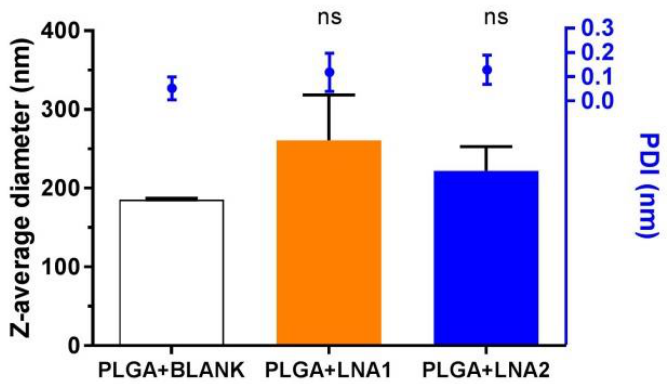
Figure 2. Variation of the Z-average size hydrodynamic diameter (nm) and polydispersity index (PDI) of PLGA NPs formed with LNA1 and LNA2. The values represented are the mean averages ± SD of three independent experiments. Statistical comparisons were performed between unloaded and loaded PLGA particles using Kruskal–Wallis test for non-parametrical distribution ( p < 0.05); “ns” stands for non-significant differences.